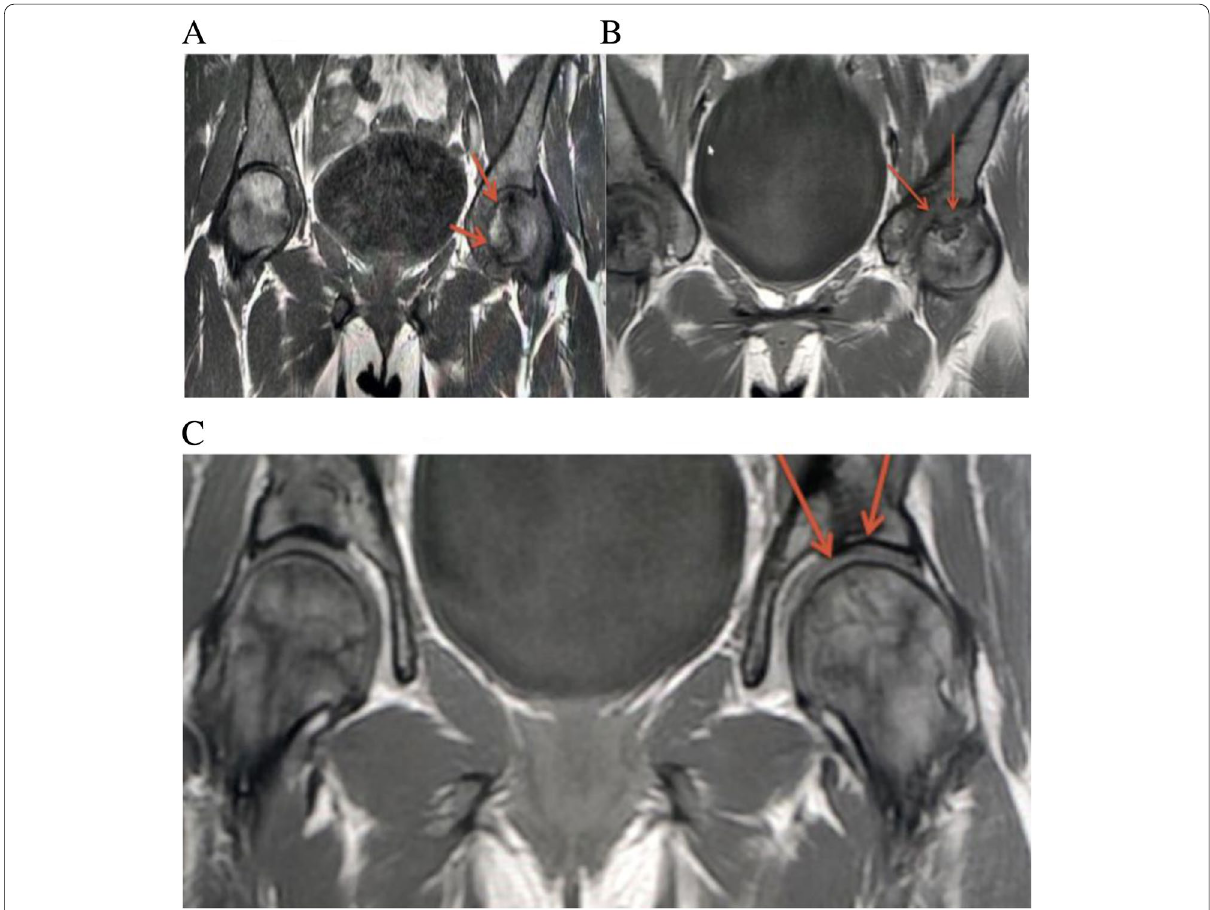
Fig. 2 A Coronal T1 weighted image of the pelvis demonstrates a large geographic area of ANFH in the anterior‑superior aspect of the left femoral head . There is no significant subchondral collapse. B Coronal T1 weighted image perfomed 4 months after demonstrates interval improvement of femoral head ANFH. C MRI done after 30 months. Coronal Short‑TI Inversion Recovery image demonstrates near complete resolution of the femoral head